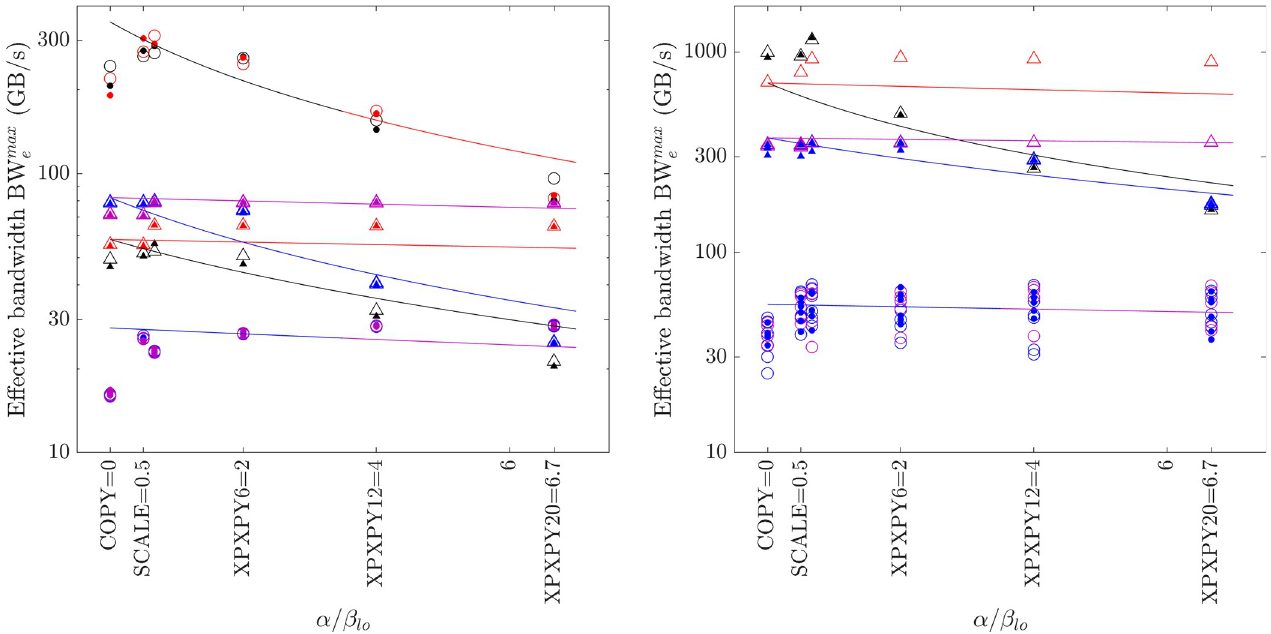
Fig 11. Model for the effective bandwidth of element-wise operations (lines = model prediction by Eq 11; symbols = measured maximal effective bandwidth; filled symbols = matrix operations; hollow symbols = vector operations; circles = CPU; triangles = GPU; black = medium f64; red = medium f32; blue = large f64; magenta = large f32). (a) PC. (b) HPC.